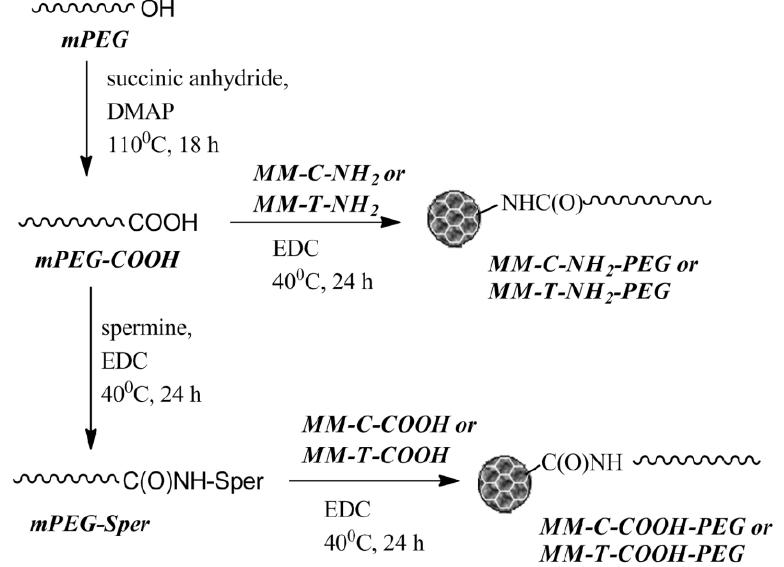
Scheme 2. Synthetic steps to obtaining PEGylated mesoporous nanoparticles.